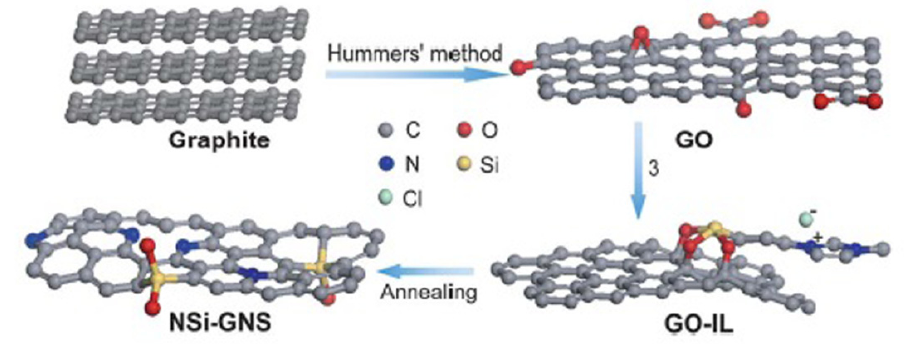
Figure 3. Schematic illustration of the synthesis of N and Si co-doped graphene nanosheets (NSi-GNS) through the high-temperature annealing of N and Si-containing graphene oxide-ionic liquid composite (GO-IL). Reprinted with permission from Ref. [127]. Copyright, 2013, Royal Society of